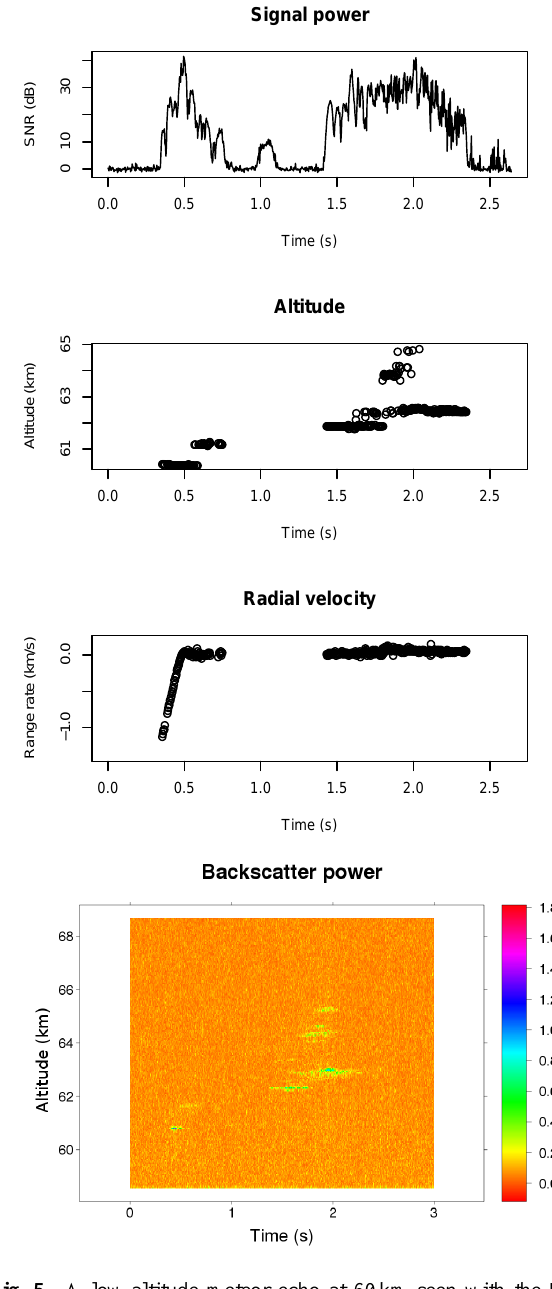
Fig. 5. A low-altitude meteor echo at 60 km seen with the EISCAT UHF radar on 19.11.2009 at 5:16 UT during a low-elevation meteor experiment. The meteor echo can been decelerating from 1 km/s down to 0, and then then echos from a trail-like structure are seen for a while. The three top panels show the results from a moving point-target model that determines the most likely range, Doppler shift and power of a point target. The fourth panel shows the range resolved backscatter power from a spread target model. After the initial head echo, many layers appear at altitudes above the initial detection. Most of the layers show 100-400 m range spread.